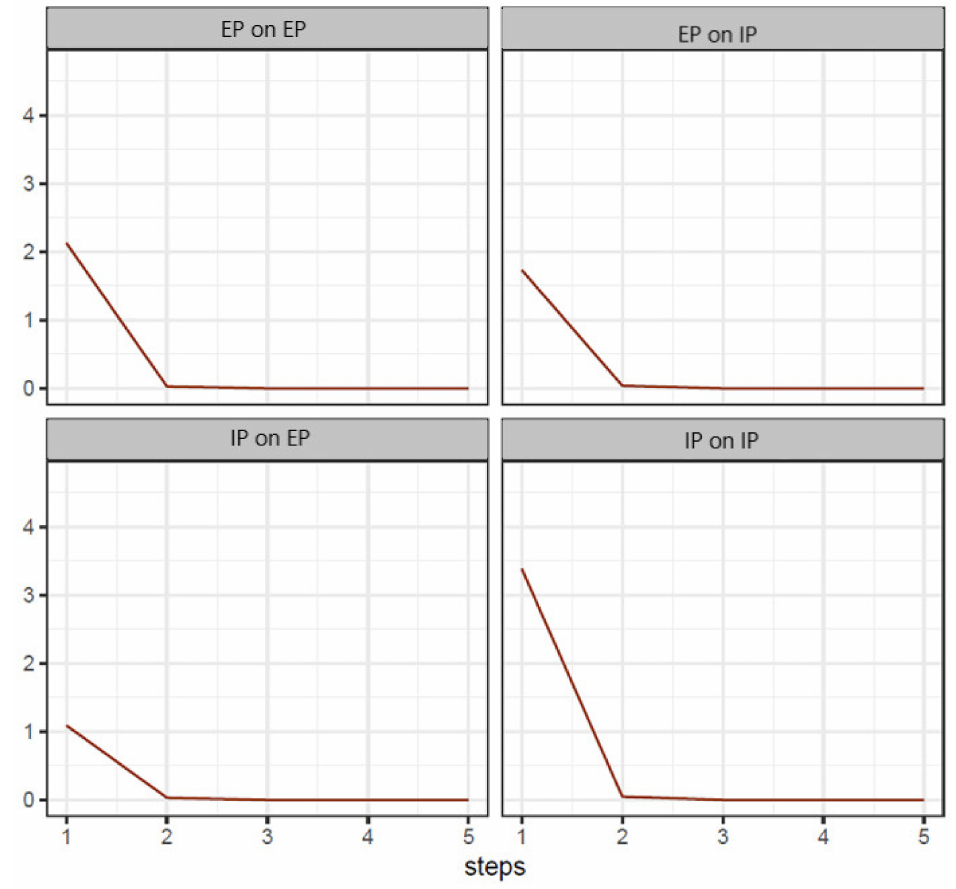
Figure 2. Impulse response functions of PVAR model with 95% confidence